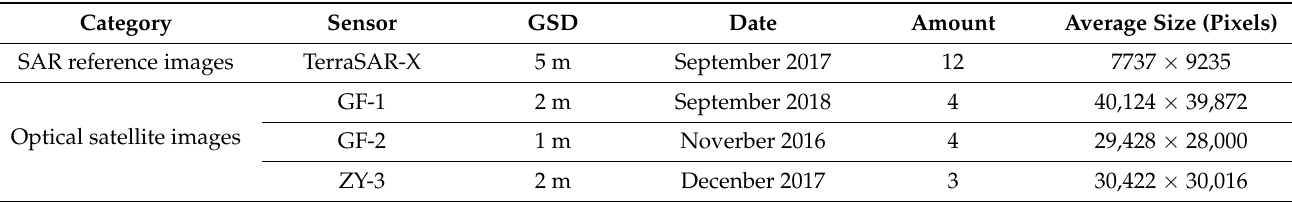
Table 4. The detailed information of all experimental image pairs used in Section